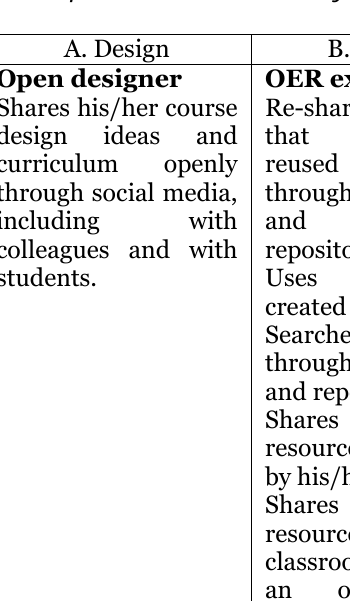
The Open Educators Factory Framework in